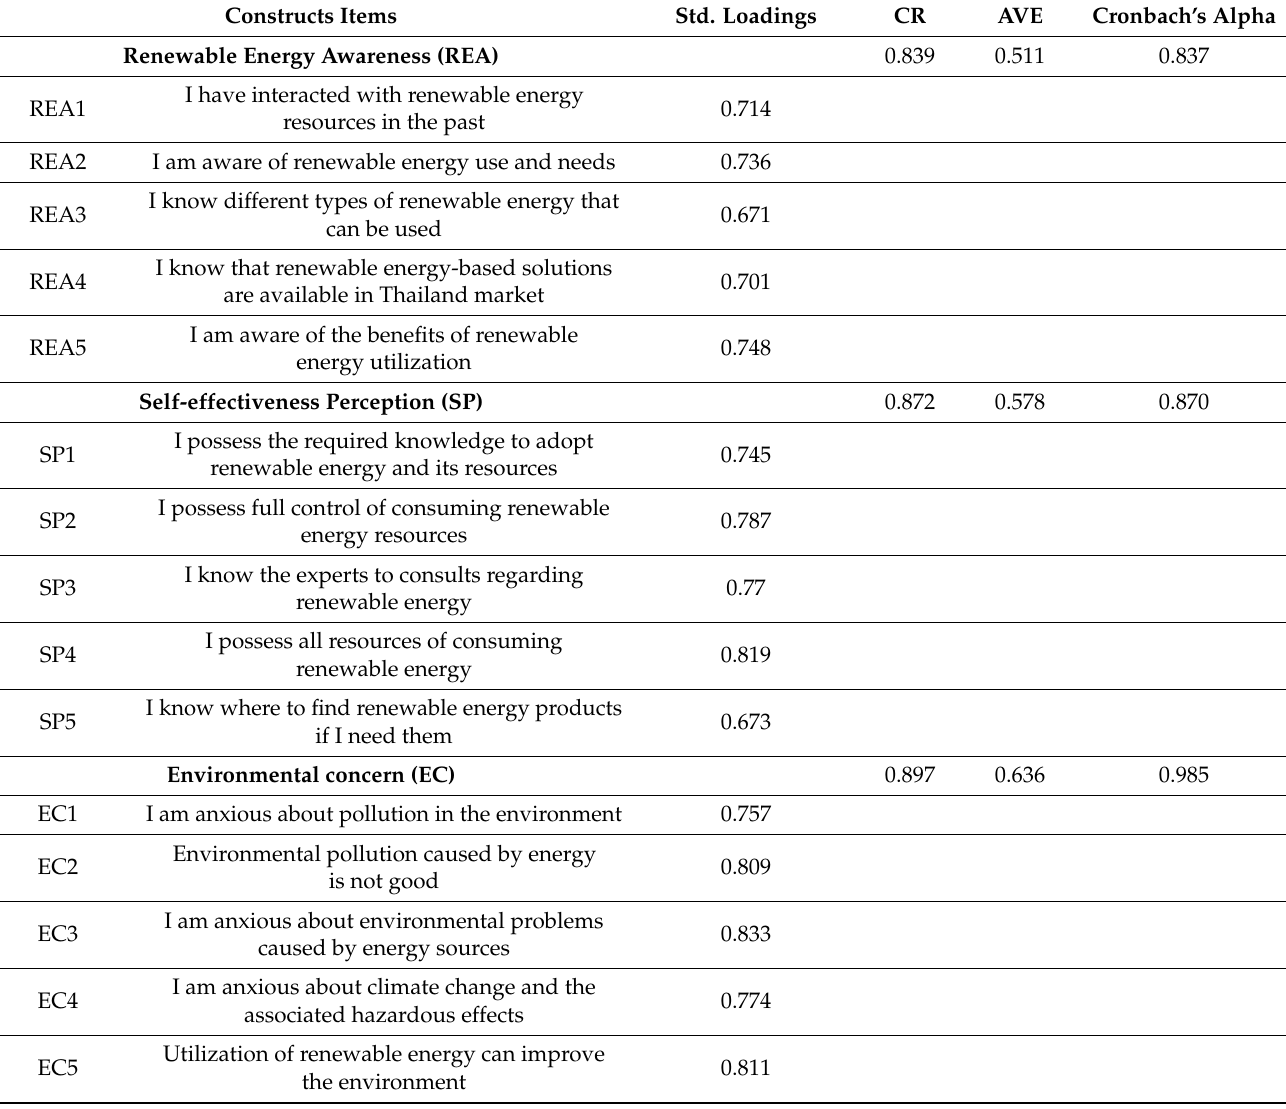
Table 2. Reliability and validity analysis of the